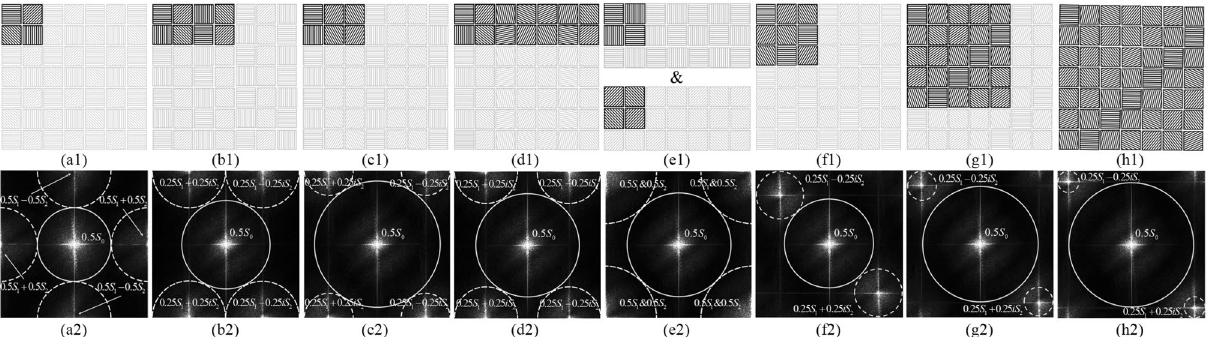
Figure 1. Eight MPA patterns and their corresponding Discrete Fourier Transform (DFT) spectra. The first row represents the ( a1 ) conventional 2 × 2 3 ( b1 ) LeMaster’s 2 × 4 7 , ( c1 ) Alenin’s 2 × 3 8 , ( d1 ) Alenin’s 2 × 7 8 , ( e1 ) Alenin’s 2 × 2 × 2 8 , ( f1 ) this work’s 3 × 3, ( g1 ) this work’s 5 × 5, ( h1 ) this work’s 7 × 7. The second row gives the spectra according to MPAs in the first